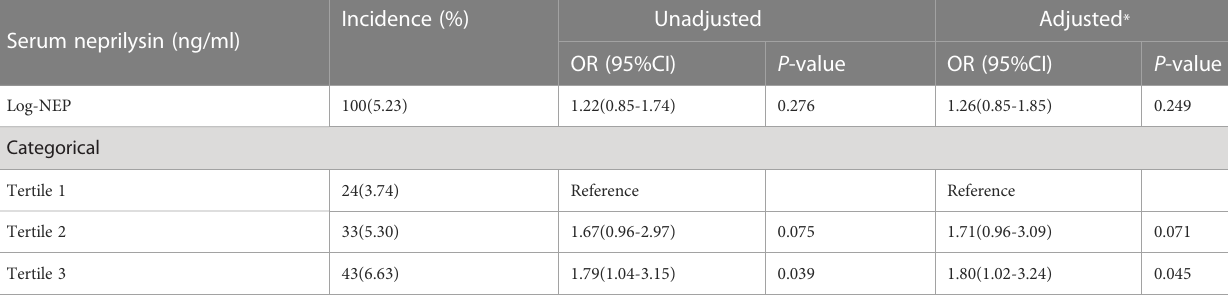
TABLE 3 The prospective association between serum neprilysin and incident diabetes during follow-up.